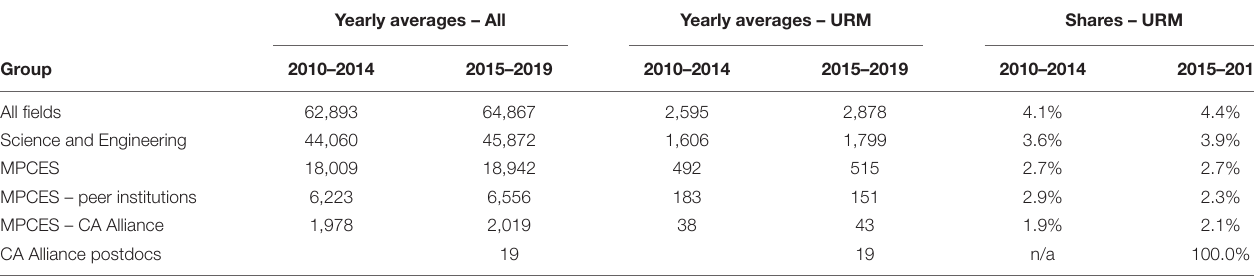
TABLE 1 | National context for URM